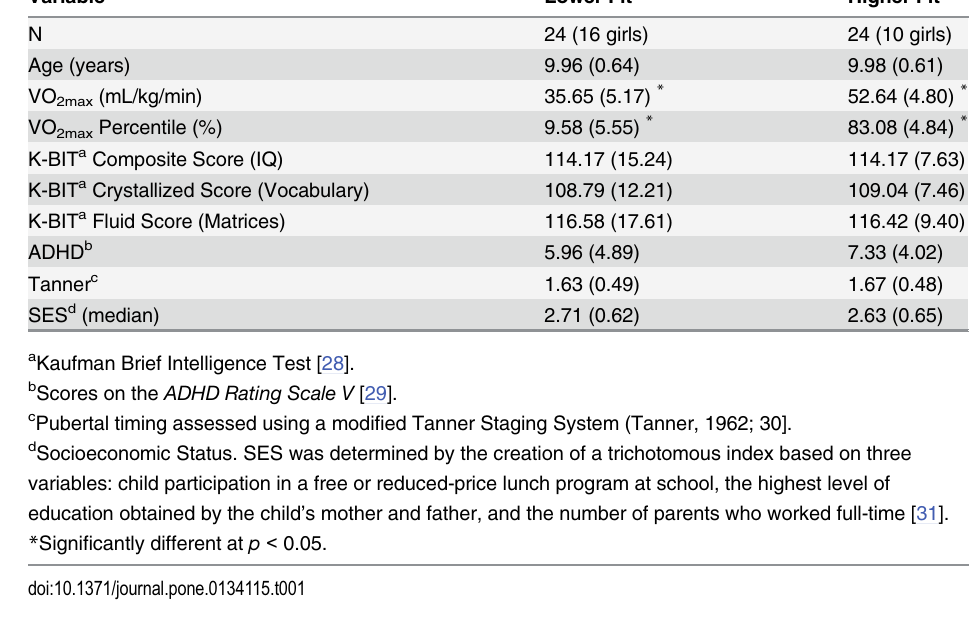
Table 1. Participant mean demographic and fitness data (SD) by aerobic fitness group.